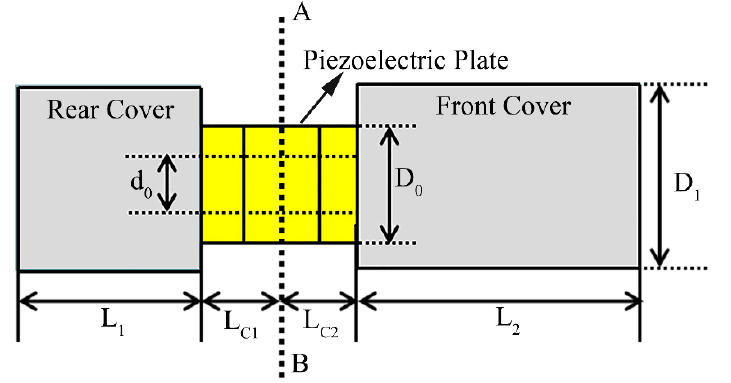
Figure 2. Schematic diagram of the ultrasonic transducer.